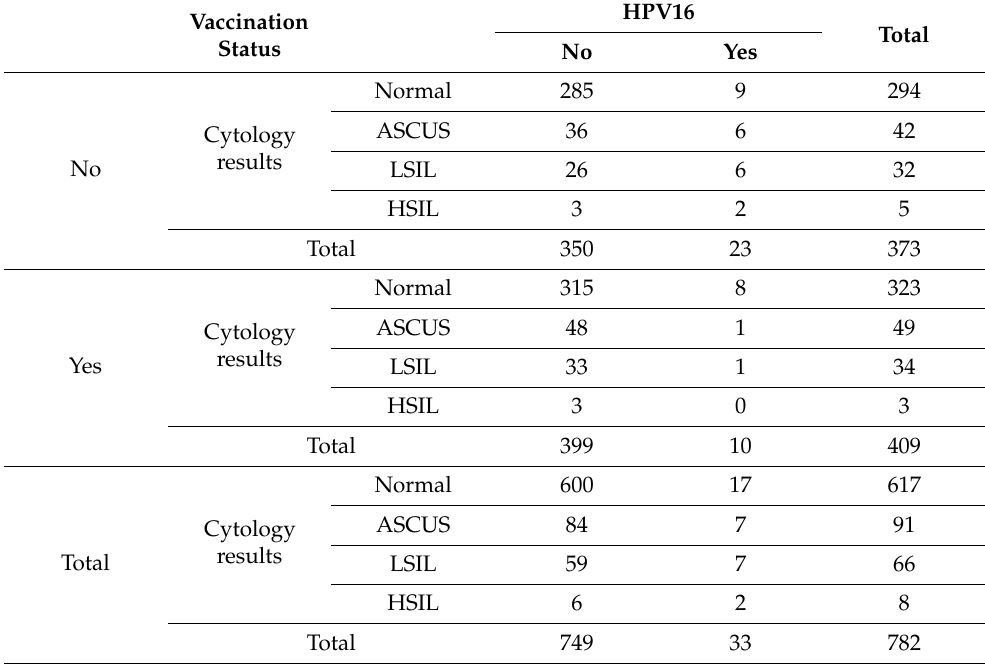
Table 8. Vaccine status and cytological result by type of abnormality in relation to the presence of